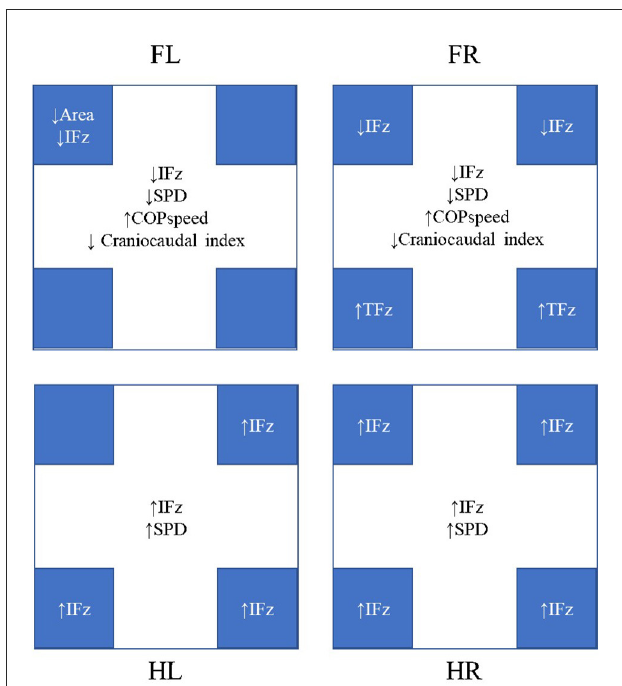
FIGURE2 Significant differences were observed during heelwork walking compared to normal walking. The results in the center of each box represent the changes in each limb, whereas the results in the blue boxes represent the changes in the quadrants. FL, left forelimb; FR, right forelimb; HL, left hindlimb; HR, right hindlimb; IFz, vertical impulse; SPD, stance phase duration; TPFz, time to peak vertical force. All mean values, standard deviations, and p -values are given in Tables 2, 4, 6,